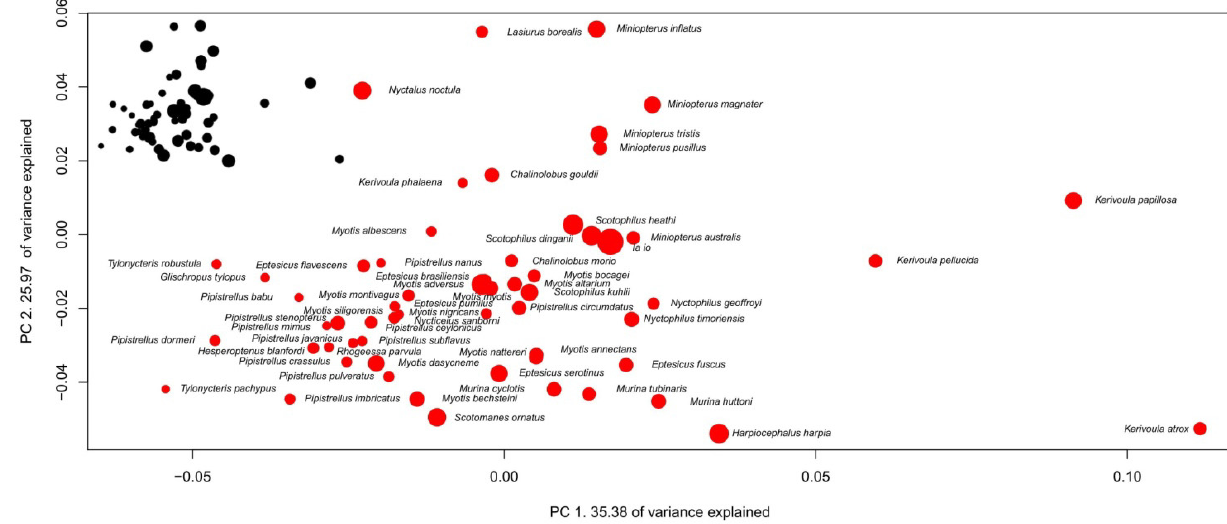
Figure 7. Phylogenetic Principal Component Analysis of Vespertilionidaes’ brain structure proportions. Regression on independent contrasts of logged absolute brain size onto independent contrasts of position on PC1: Multiple R -squared: 0.160, F -statistic: 10.85 on 1 and 57 DF, P = 0.001702; PC2: Multiple R -squared: 0.0047, F -statistic: 0.2666 on 1 and 57 DF, P =